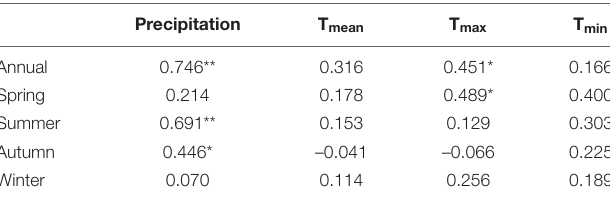
TABLE 1 | Correlations between climate factors and AGB of marsh vegetation in the western Songnen Plain marshes.